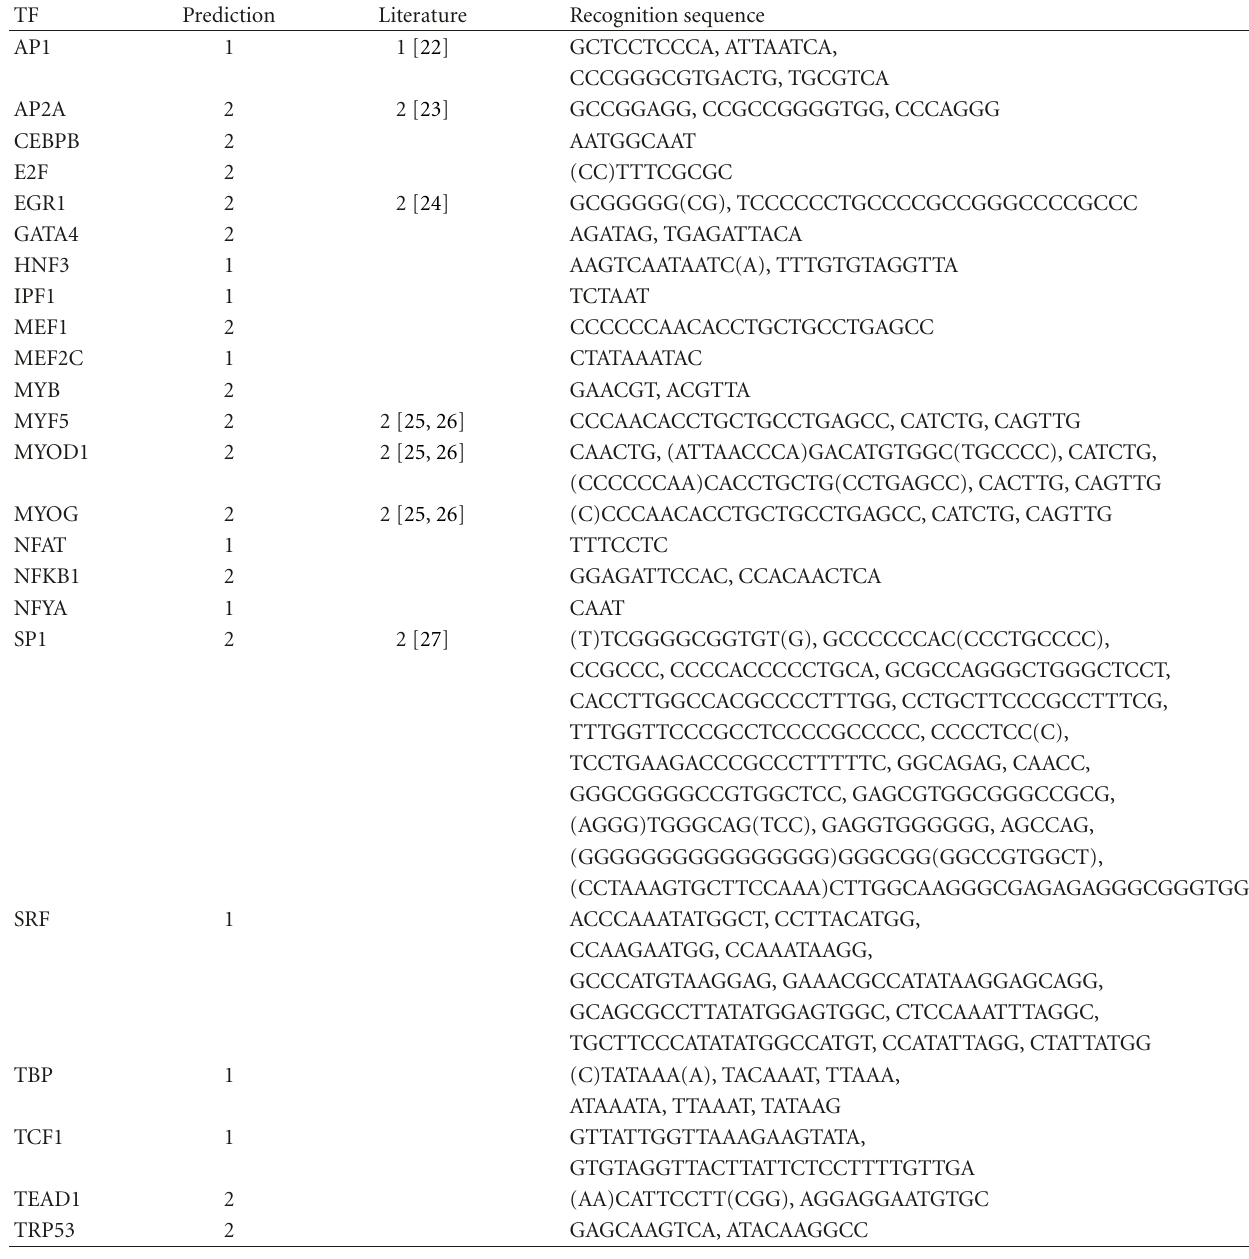
Table 3: Transcription factors used in this study. “1” and “2” each represents that the corresponding TF binds to DNA in a single and double strand manner, respectively. Empty blank means no literature information is